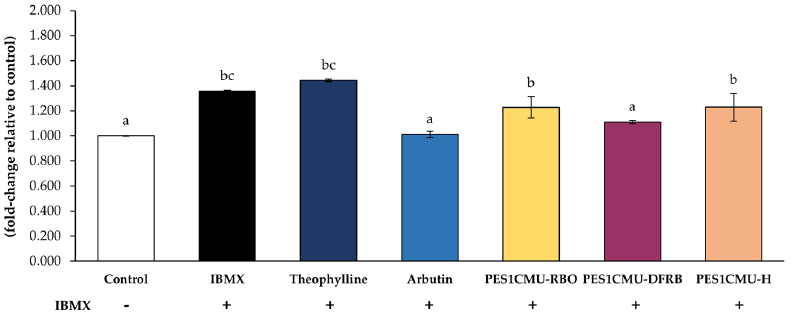
Figure 2. Effects of rice bran oil (PES1CMU − RBO), defatted rice bran extract (PES1CMU − DFRB), and husk extract (PES1CMU − H) of Oryza sativa L. cv. PES1CMU on intracellular melanin content in